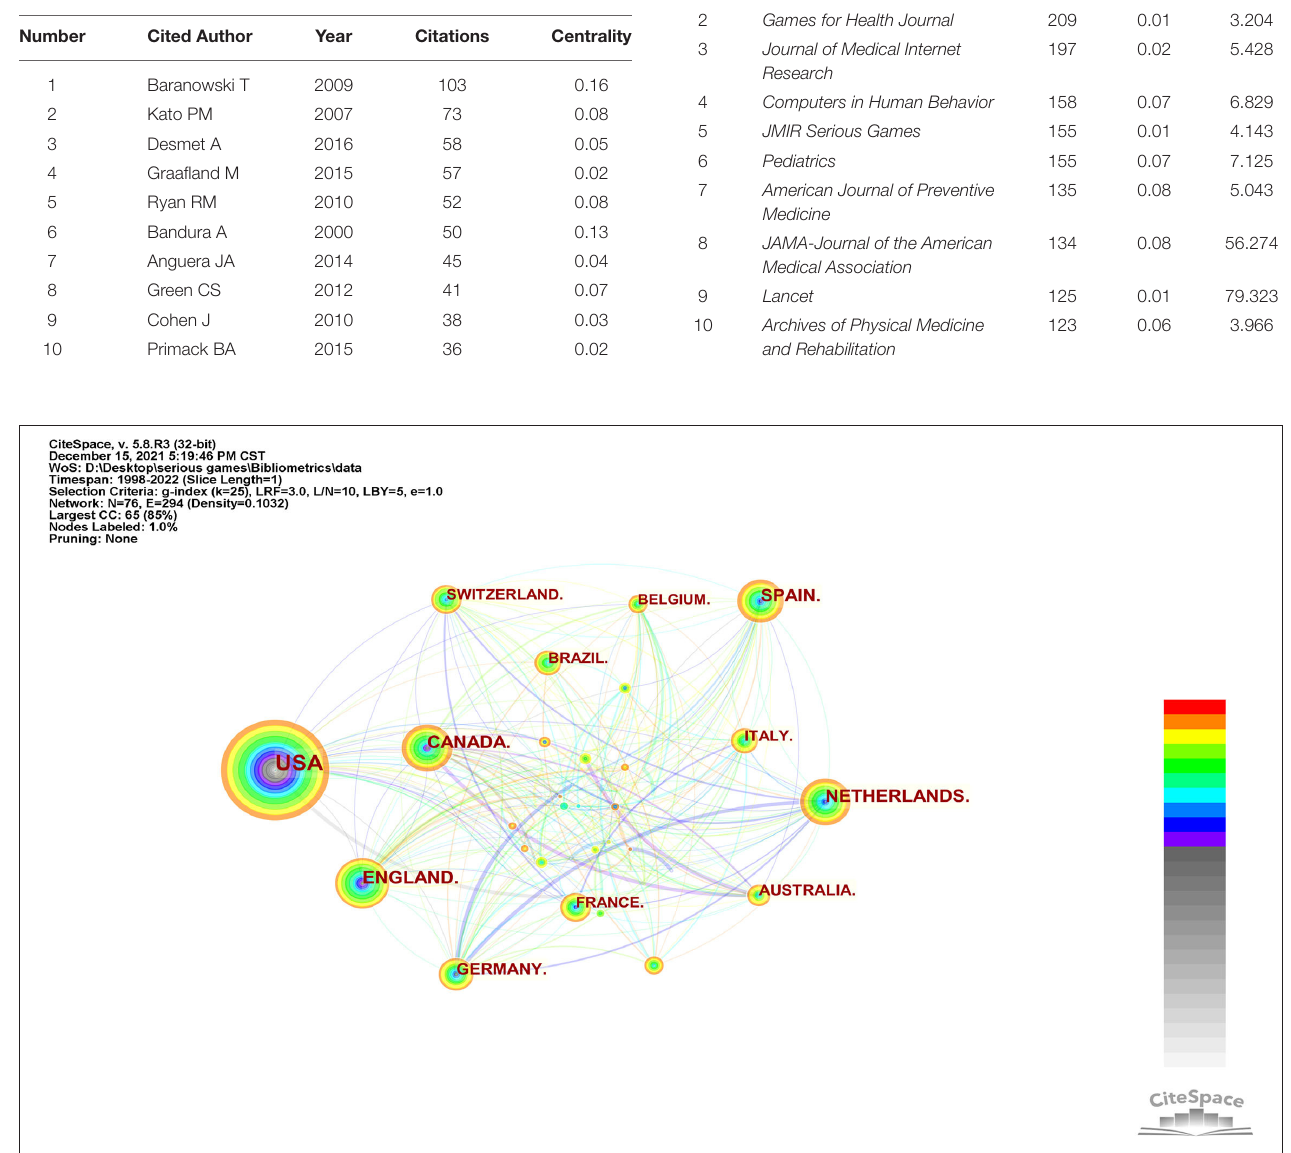
FIGURE 4 | Countries’ collaboration